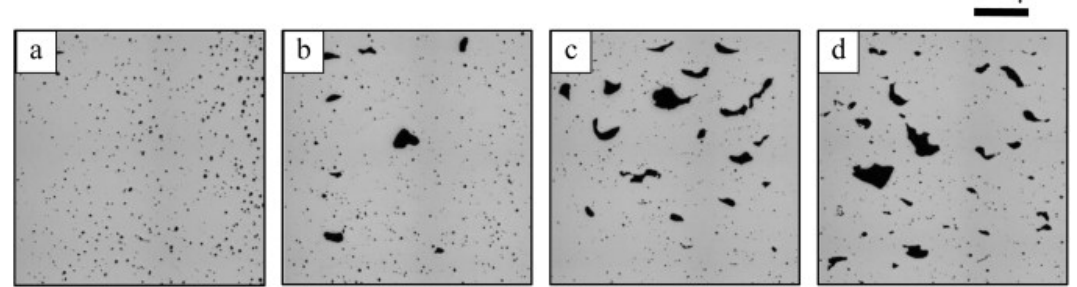
Figure 33. Evolution of pores in SLM-processed AlSi10Mg as a function of laser scan speed: ( a ) 250 mm/s, ( b ) 500 mm/s, ( c ) 750 mm/s and ( d ) 1000 mm/s [76]. Copyright 2014. Adapted from Elsevier Science Ltd. (Figure 5 [76]).